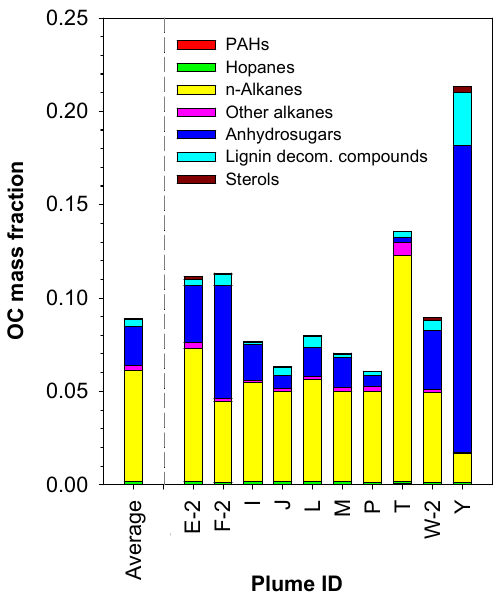
Figure 3. Organic carbon mass fraction of the speciated compound classes in selected peat-burning emission samples. Plume Y was excluded from the average calculation as discussed in Sect. 2.1.